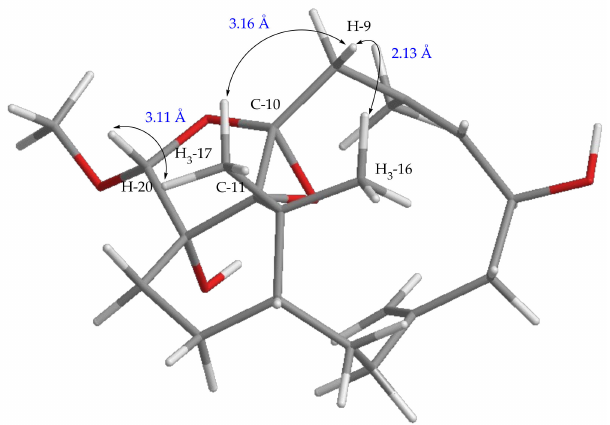
Figure 8. The distance H 3 -16/H-9, H 3 -17/H-9, and H 3 -17/H-20 of the relative configuration of C-10 and C-11 in isomeric compound 5 .